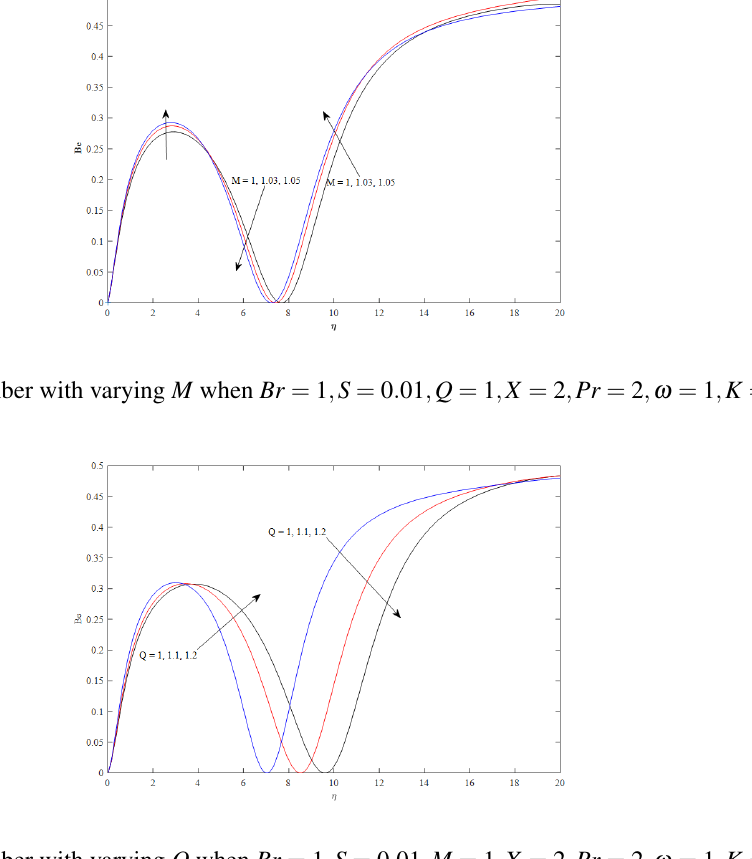
Fig. 9 Bejan number with varying Q when Br = 1 , S = 0 . 01 , M = 1 , X = 2 , Pr = 2 , ω = 1 , K = 0 . 95 .